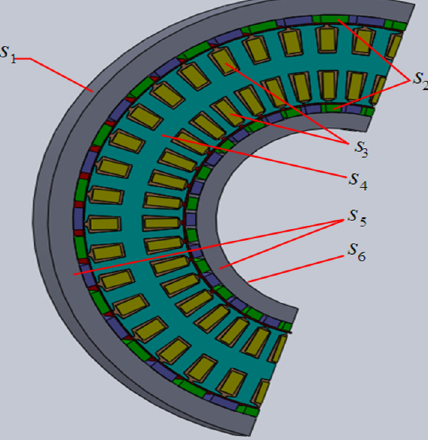
Figure 9. Different boundary surfaces of 3-D DRPMSM